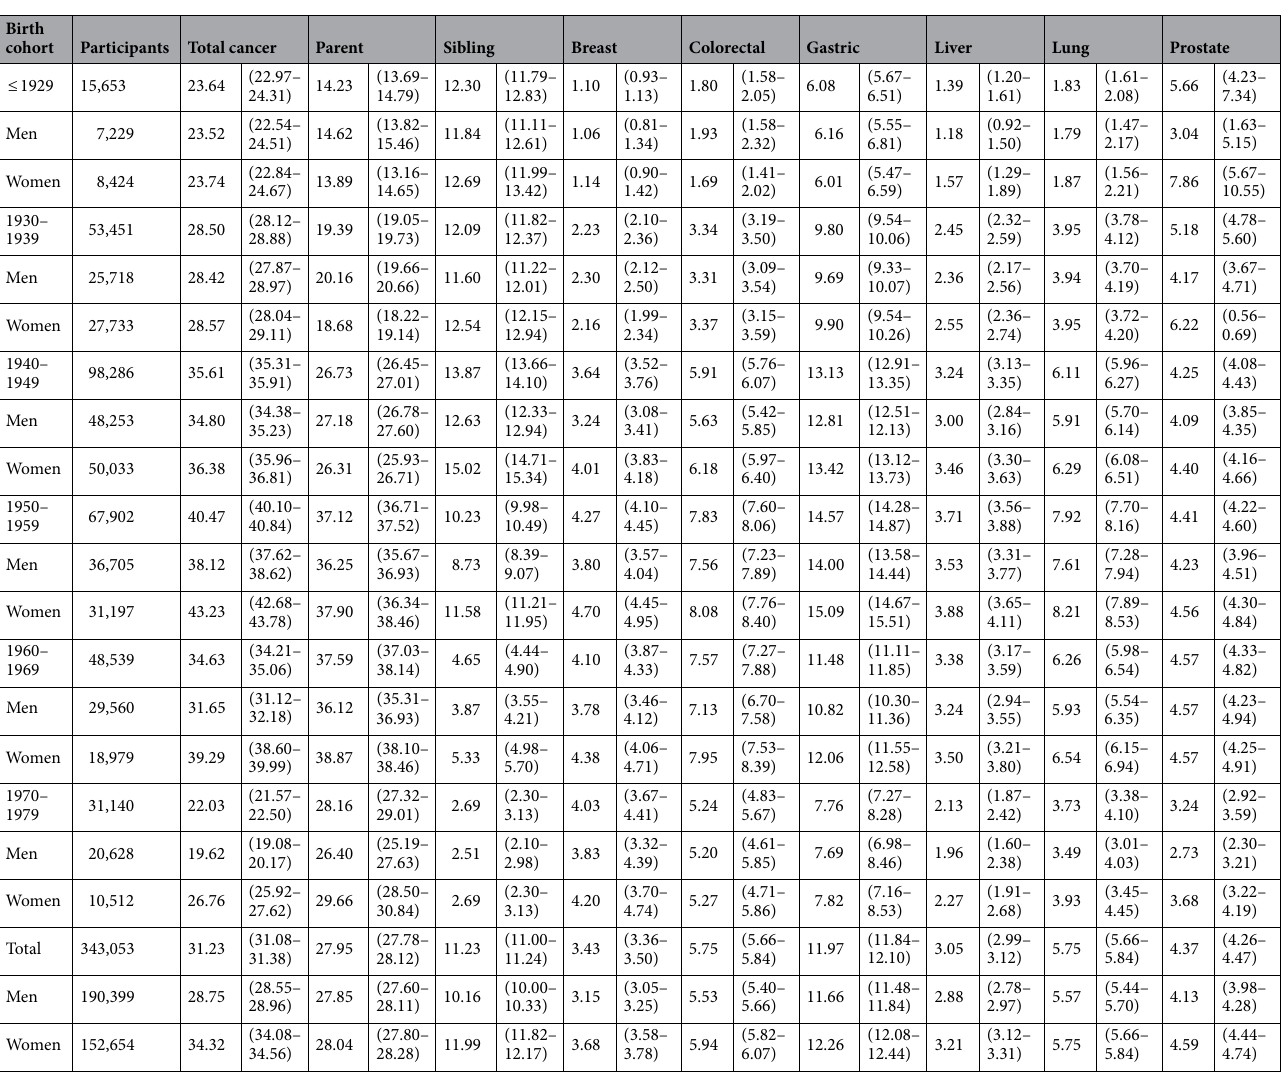
Table 3. Prevalance of family history of cancer and corresponding 95% confidence intervals by birth cohort in seven Japanese cohort studies. Participants for family history of total cancer; total includes those birth year is > 1980; J-ECOH only total cancer; Suita only total, parent and sibling; > 1980 only total cancer J-ECOH participants 28,082; prevalence 7.33 (95%CI: